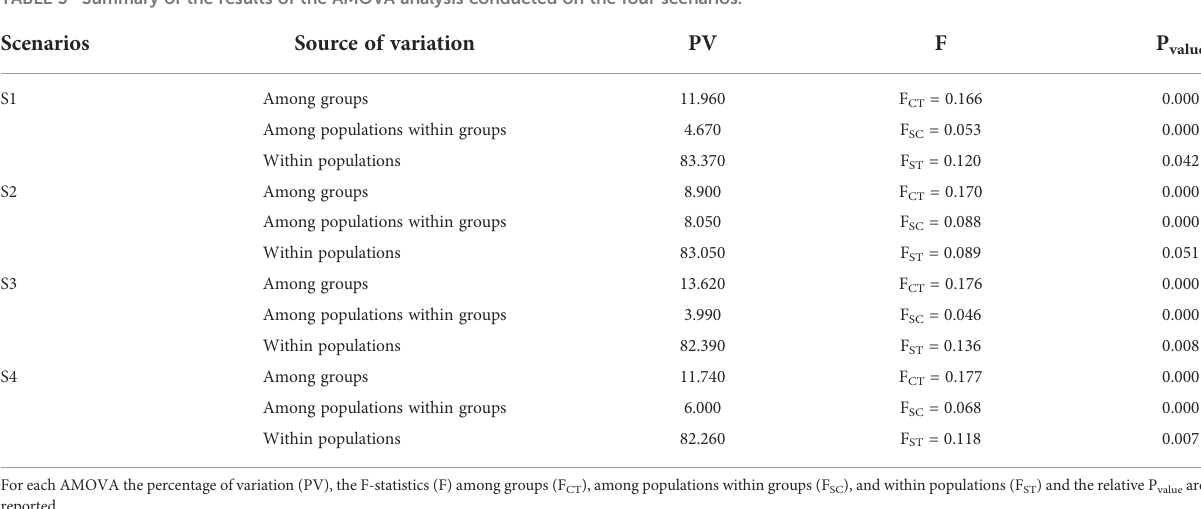
TABLE 3 Summary of the results of the AMOVA analysis conducted on the four scenarios.